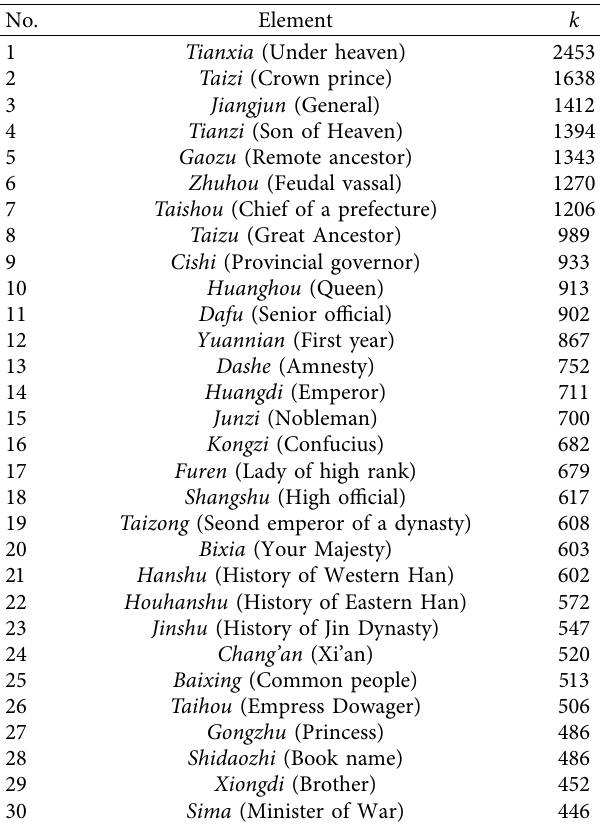
Figure 3: Log-log scatter plot of degree distribution for the complex network of Traditional Chinese cultural elements. Table 5: Top 30 cultural elements with highest